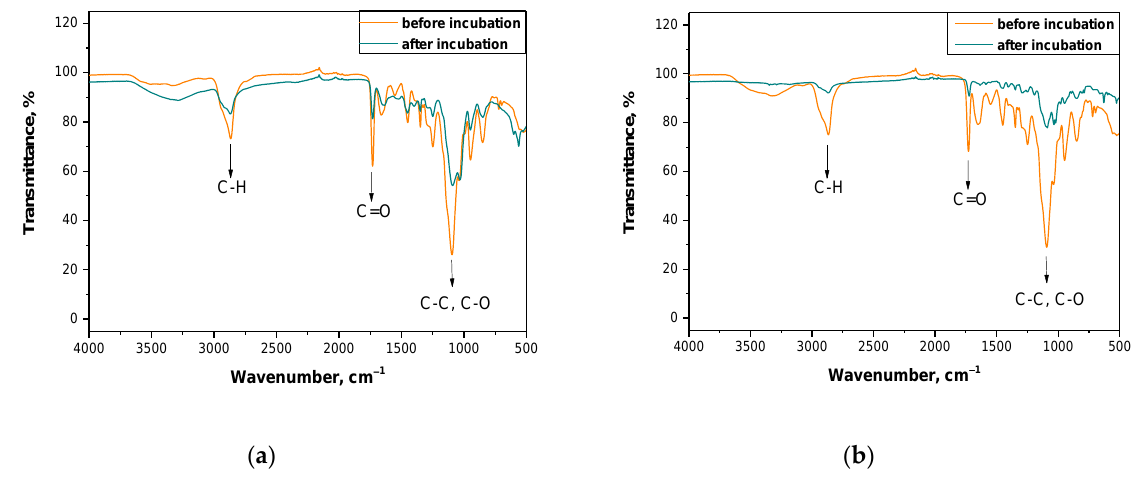
Figure 6. FT-IR spectra of ( a ) sample 0/1.6; ( b ) sample 0/3.2.